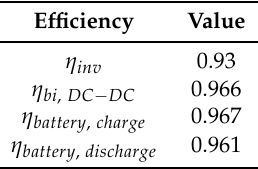
Table 1. Relevant efficiencies for the household energy system.